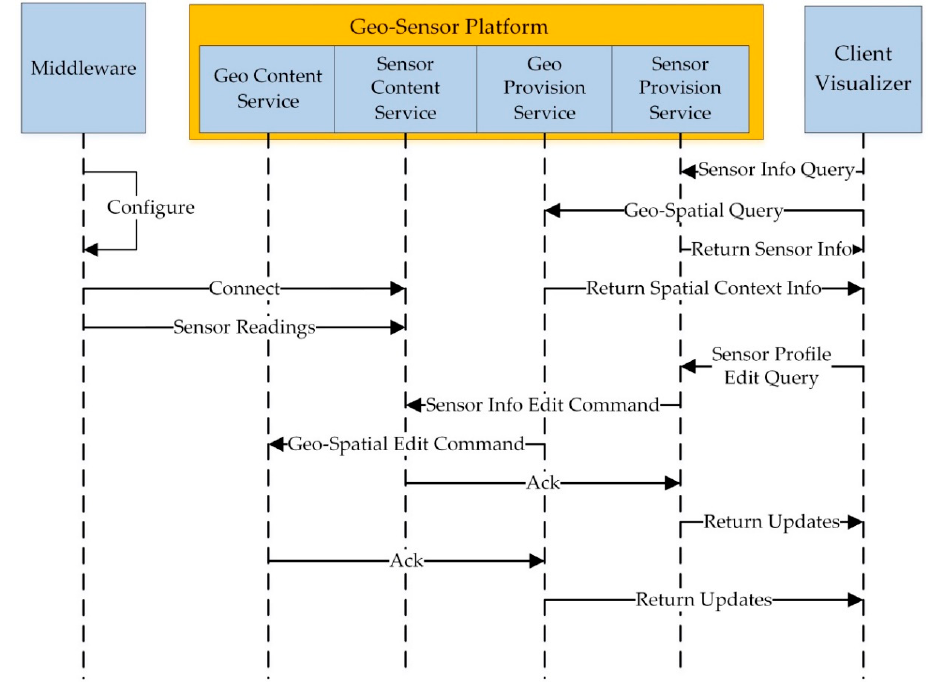
Figure 6. Geo-Sensor Service Provision Service Sequence Diagram .